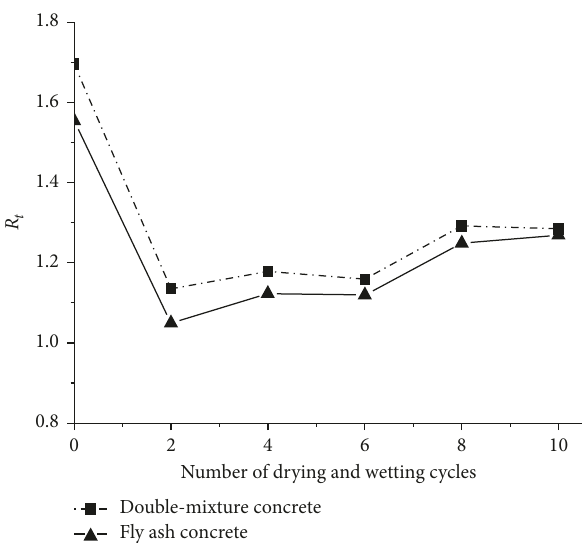
Figure 8: Relative splitting tensile strength ratio of modified concrete corroded by (NH 4 ) 2 SO 4 solution.